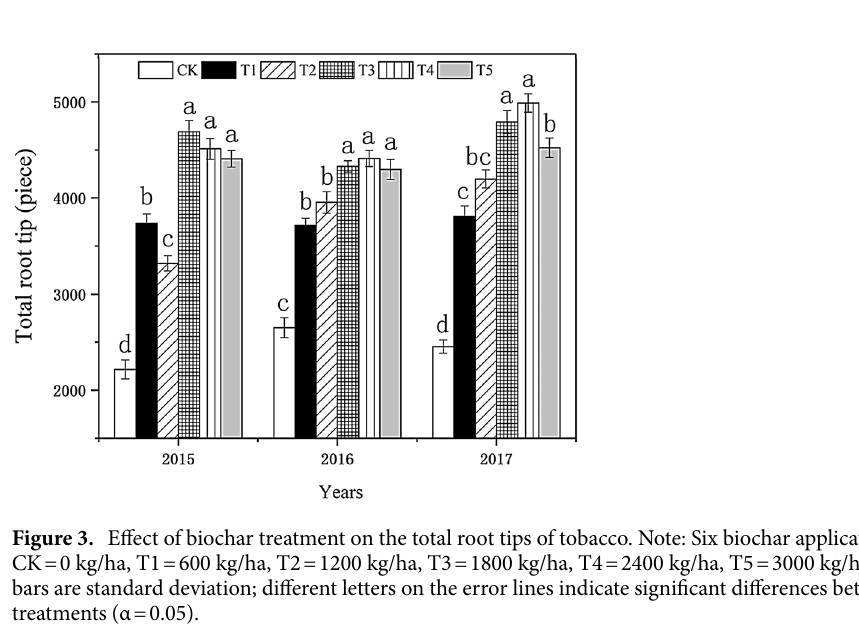
Figure 2. Effect of biochar treatment on total surface area of tobacco roots. Note: Six biochar application levels: CK = 0 kg/ha, T1 = 600 kg/ha, T2 = 1200 kg/ha, T3 = 1800 kg/ha, T4 = 2400 kg/ha, T5 = 3000 kg/ha; The error bars are standard deviation; different letters on the error lines indicate significant differences between different treatments (α = 0.05).